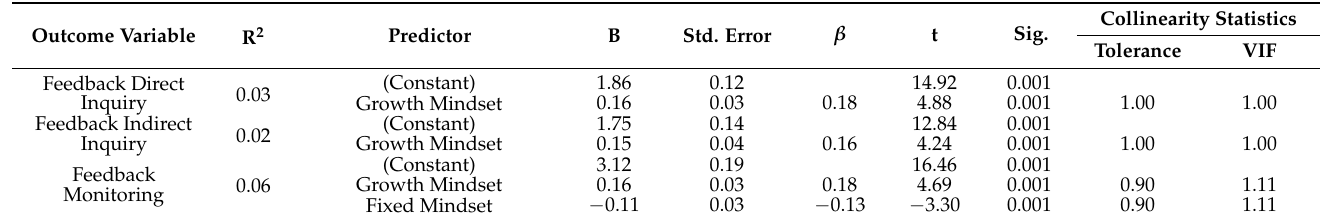
Table 4. Predictive Roles of Chinese EFL Learners’ English Mindsets on FSB.